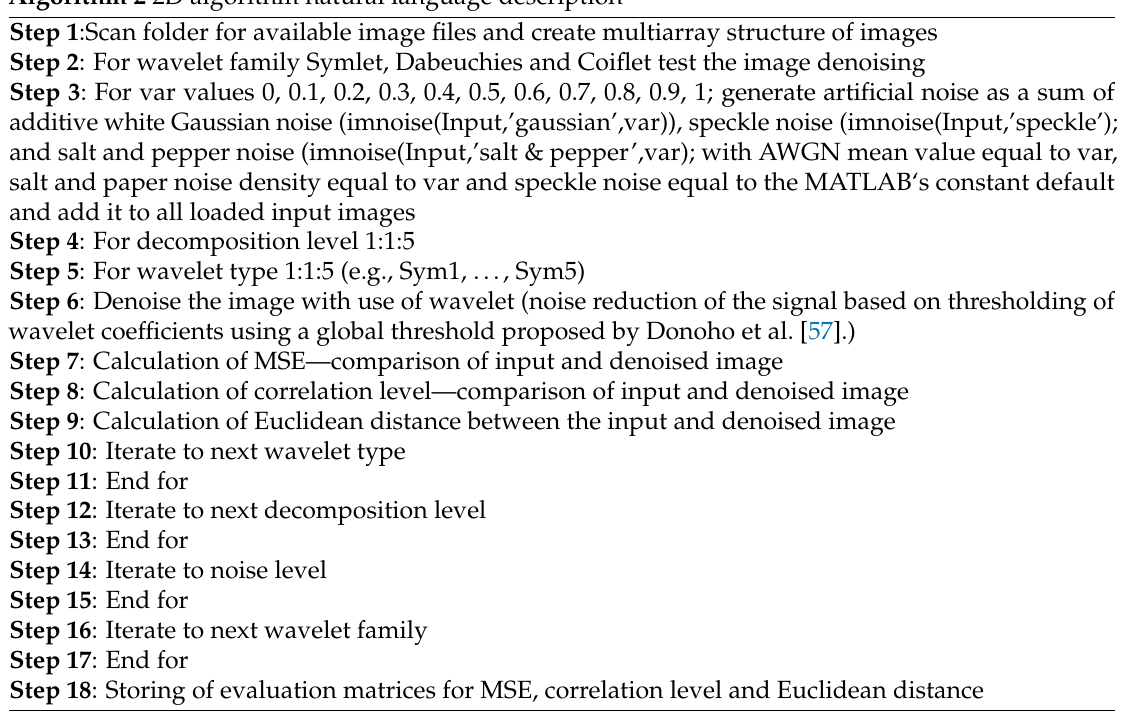
Algorithm 2 2D algorithm natural language description